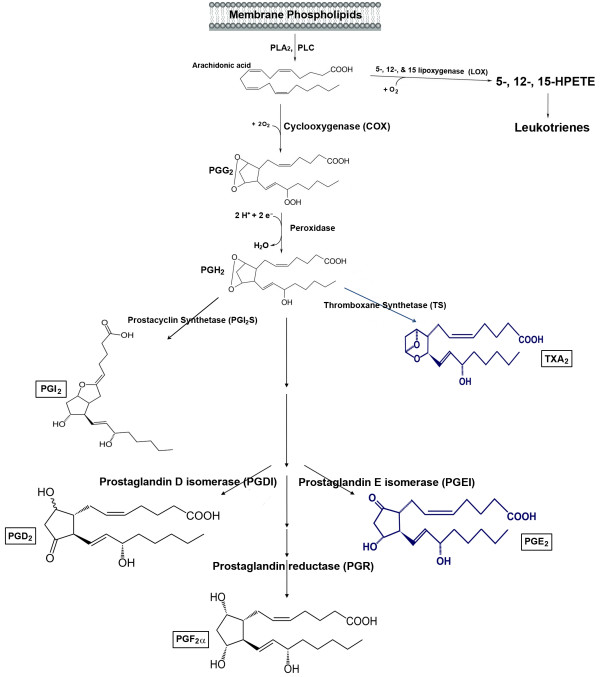
A schematic representation of the arachidonic acid metabolism pathway. After its liberation by phospholipases, ((i.e., phospholipase A2 (PLA2) or phospholipase C (PLC)), the free arachidonic acid may undergo enzymatic metabolism by the lipoxygenases which produce HPETEs and leukotrienes, and the cyclooxygenases (COX-1, COX-2) which generate prostaglandins and thromboxanes. The specific repertoire of the arachidonic acid metabolites produced may vary according to the expression profile of these enzymes in different cell types. In platelets, for example, arachidonic acid is metabolized by COX-1 into the prostaglandin endoperoxides, PGG2 and PGH2. Next, thromboxane synthetase further metabolizes PGH2 into TXA2, which is a potent activator of platelet aggregation, with a half-life of 20-30 seconds. Thromboxane A2 is then hydrolyzed to the inactive form TXB2 (not shown). On the other hand, if PGH2 is metabolized by prostacyclin synthetase, then PGI2 would be produced (e.g., in endothelial cells). Furthermore, if PGH2 is acted upon by PGD or PGE isomerase, then PGD2, and PGE2 are produced, respectively (e.g., in renal cells). Finally, if the PG reductase metabolizes PGH2, then PGF2α is produced (e.g., pulmonary vessels). Thus, the biological functions of arachidonic acid are exerted indirectly after its metabolism into prostaglandin and thromboxane metabolites.